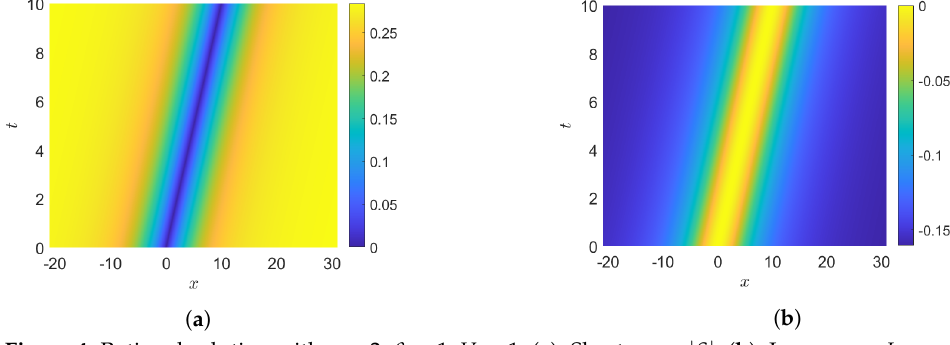
Figure 4. Rational solution with α = 2, β = 1, V = 1. ( a ). Short wave | S | . ( b ). Long wave L